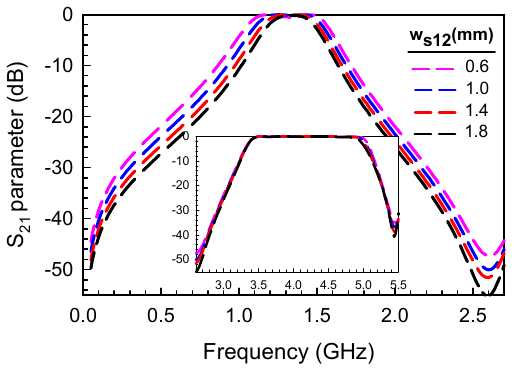
Figure 15. Effect of varying w s12 on the bandwidth of the first passband.